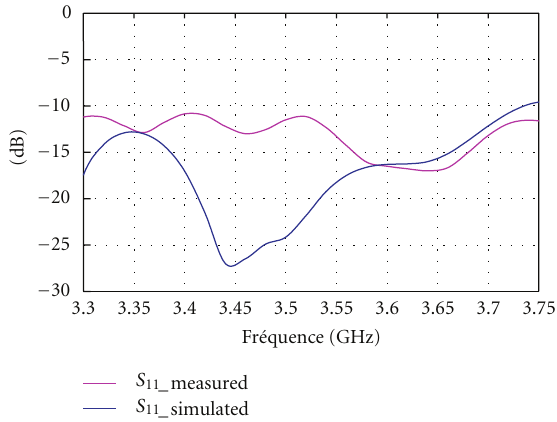
Figure 15: Comparison of return loss between cosimulation and measures.